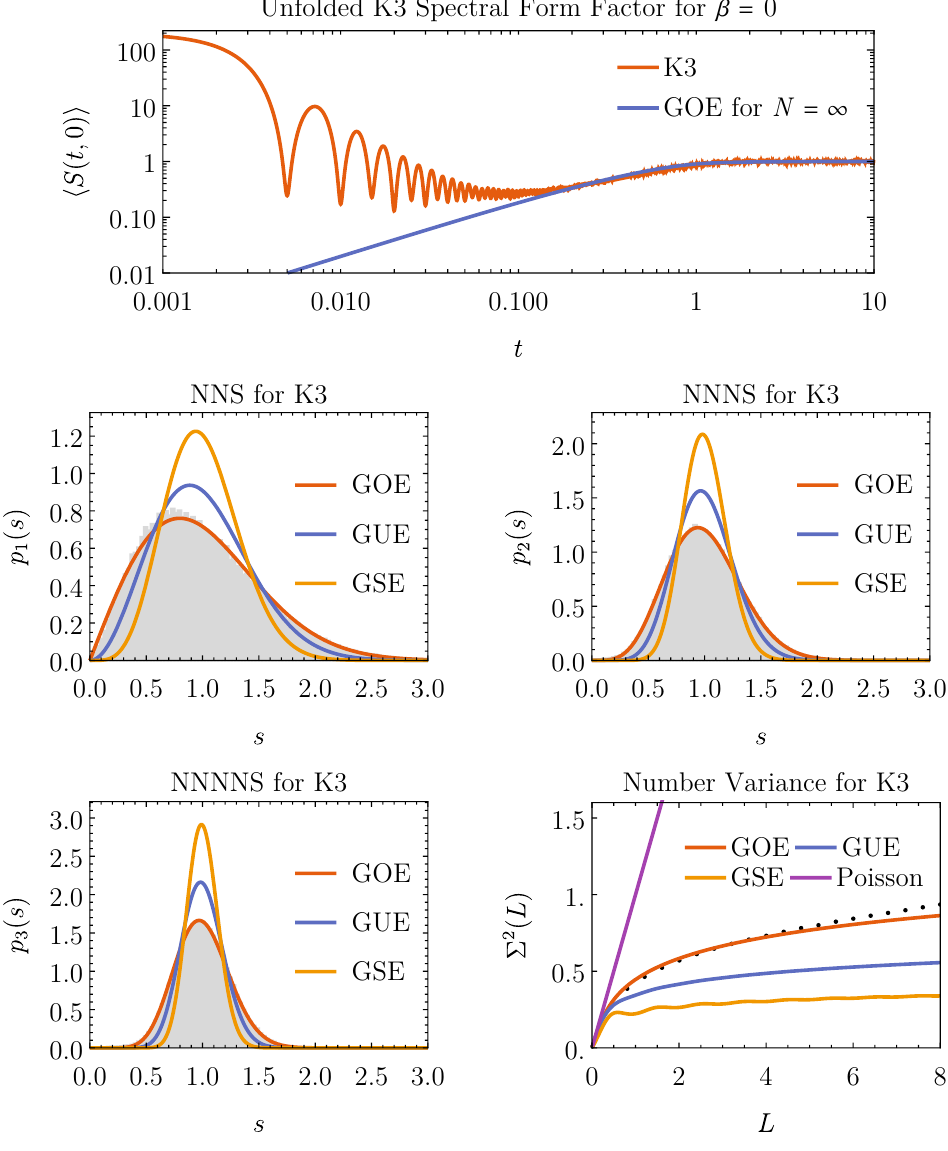
Figure 6 . The top row shows the unfolded spectral form factor for β = 0 for K3 surfaces. The orange curve shows an ensemble average consisting of 1,000 samples in complex structure moduli space with each sample containing the lowest-lying 200 eigenvalues. The dip, ramp and plateau are all present. The second and third rows display certain spectral statistics together with fits to GOE. (Other matrix ensembles are also shown for comparison.) The second row shows the nearest-neighbor level spacings (NNS) and the next-to-nearest (NNNS). The third row shows the next-to-next-to-nearest (NNNNS) level spacings and the number